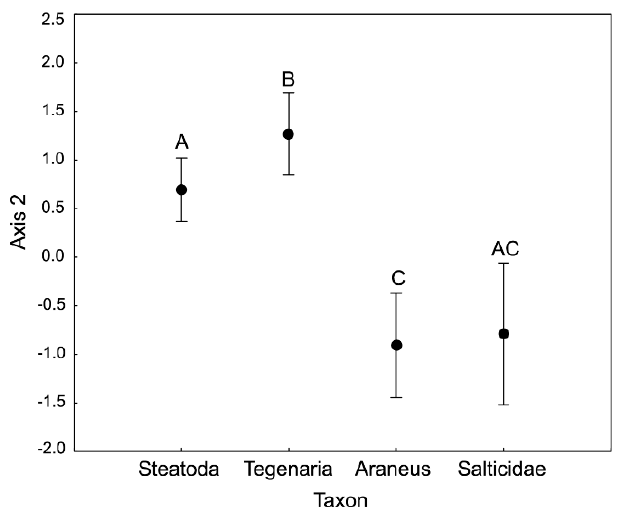
Figure 4. Multivariate analysis of stoichiometric relations in the four taxa of spiders (PCA). ANOVA performed for the 2nd axis scores. Different letters denote significant differences in multielemental stoichiometry between taxa (F = 3.78, p < 0.00001). Bars denote the confidence intervals. Table 1 provides information on the contribution of different elements to the scores of Axis 2.